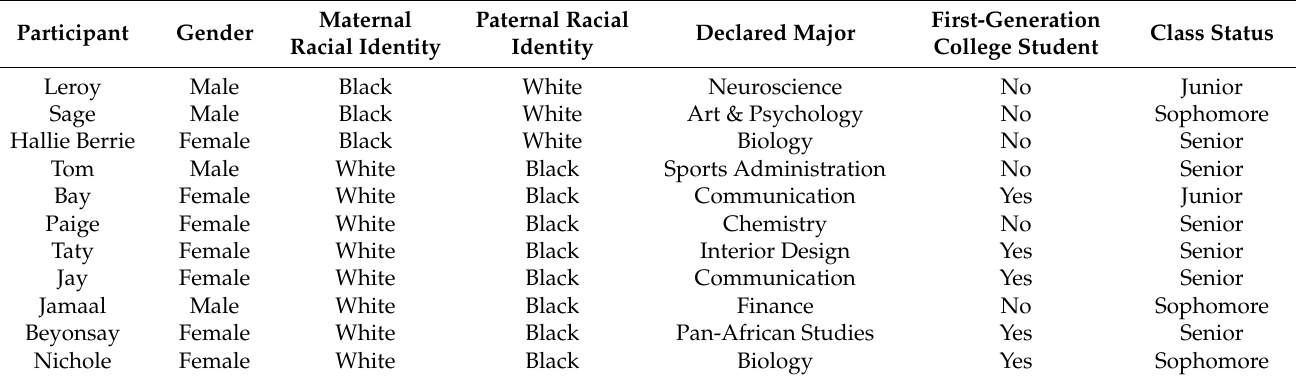
Table 1. Multiracial